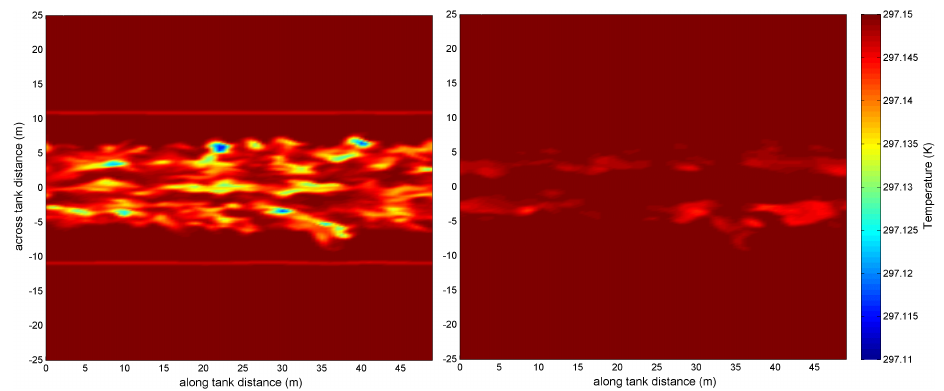
Figure 1. Top view of temperature field (in kelvin, at time t = 575s) for ship wake model in the presence of an ambient stratification illustrates the upwelling of colder subsurface water by the circulation in the ship wake. Left: at depth 0.5m; right: at depth 5mm. The temperature difference at the surface is small in our case, but is expected to be more pronounced in the case of a larger near-surface temperature gradient and stronger wake circulation.